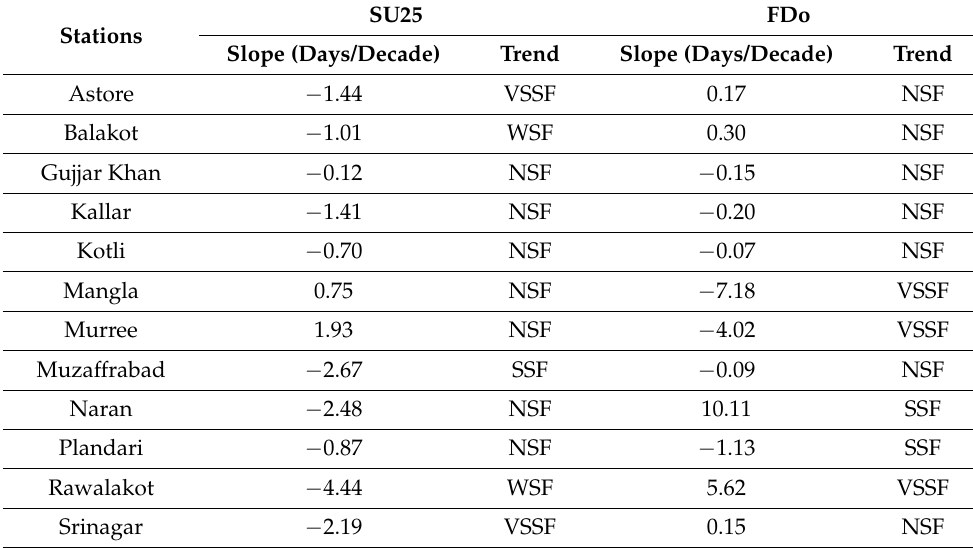
Table 4. Trends of absolute temperature indices slopes and trends.